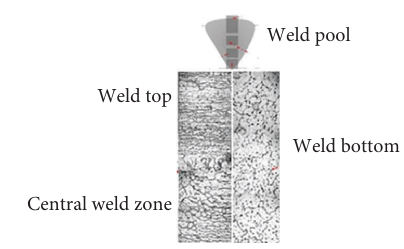
Figure 2: Microstructure of weld fabricated at 100amp.